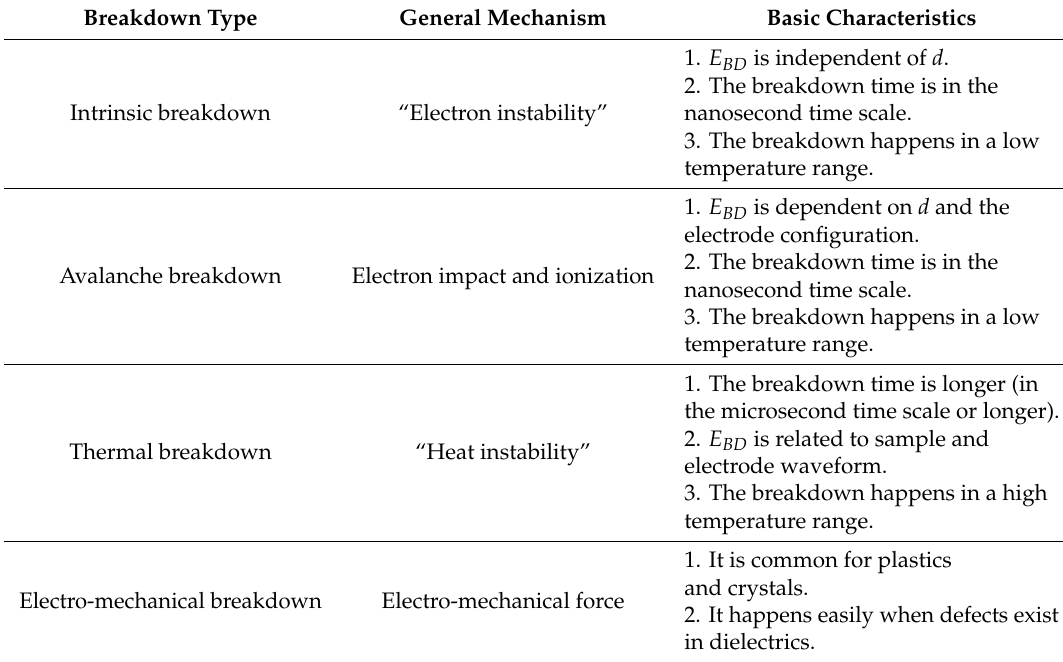
Table 1. Summary of classical breakdown